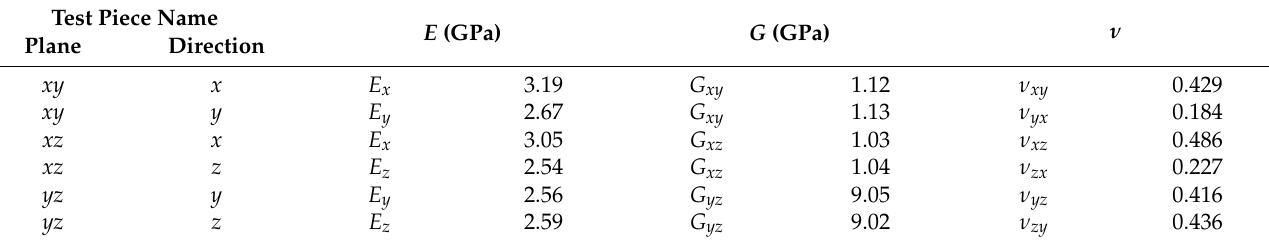
Table 3. Measured results of test pieces with different